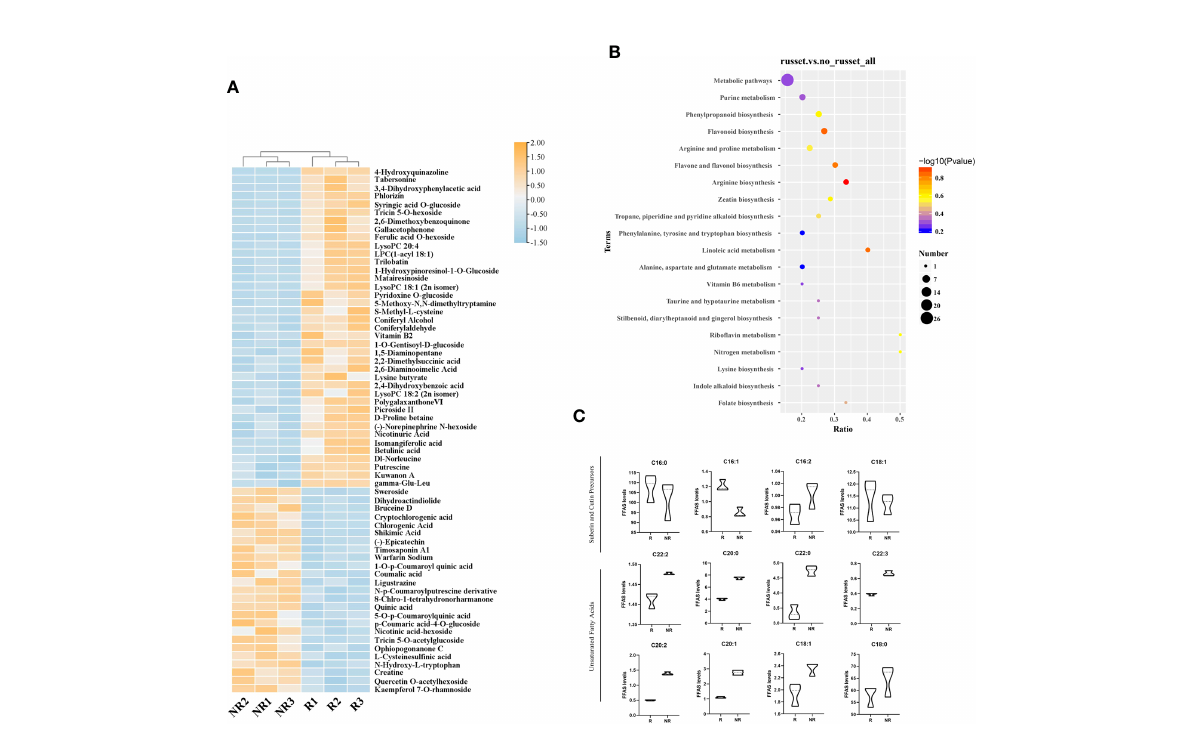
FIGURE 3 DAM analysis in russet and non-russet apples. (A) The heatmap shows the DAMs identi fi ed using LC-MS. Orange represents upregulated DAMs, and blue represents downregulated DAMs. (B) KEGG enrichment analysis of the DAMs in the two fruits. (C) Metabolite contents in the two